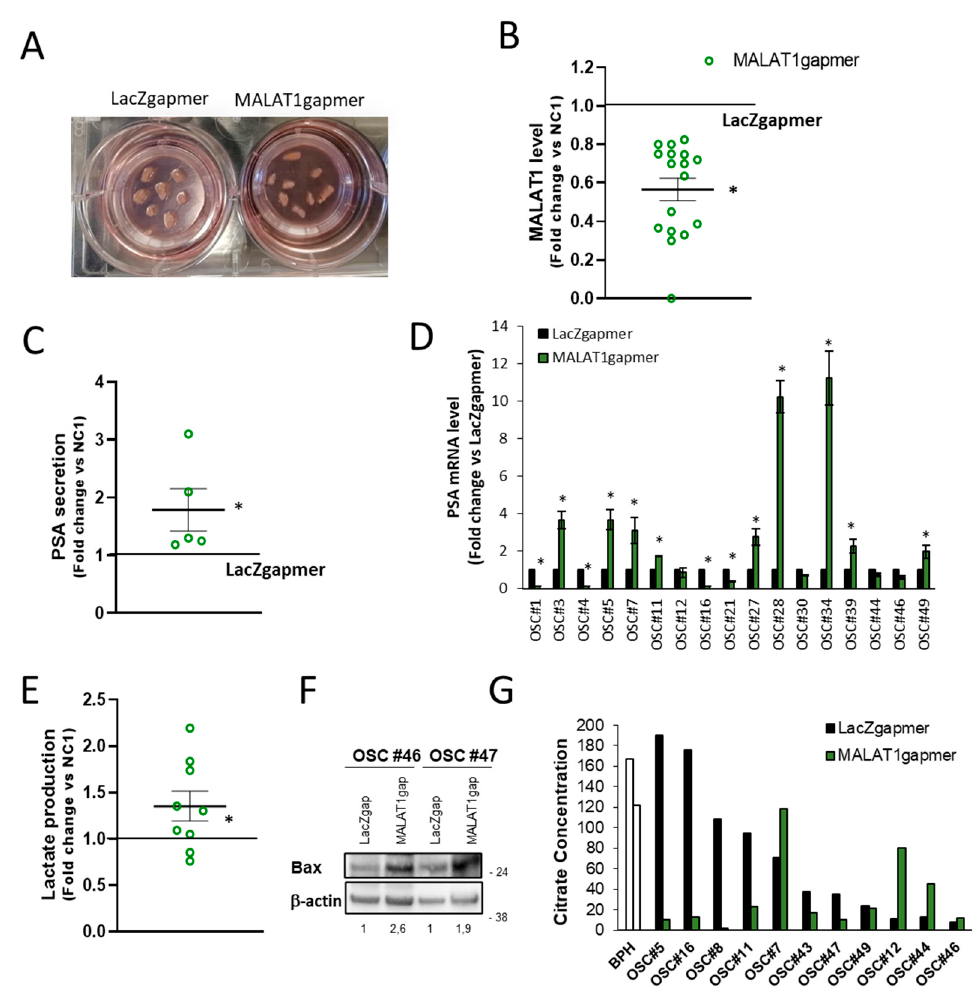
Figure 8. Organotypic slice cultures of prostate tumors and in vivo effects of MALAT1 depletion. ( A ) Image of representative human PCa organotypic slice cultures (OSCs) obtained from intra-operatory prostate cancer specimens transfected with specific (MALAT1) or control (LacZ) gapmer. ( B ) MALAT1 expression level was quantified by qRT-PCR in OSCs ( n = 17) at 72 h after transfection with specific MALAT1gapmer or LacZgapmer. ( C ) PSA concentration measured in the extracellular medium of OSCs ( n = 5) at 24h after transfection with MALAT1gapmer or LacZgapmer. ( D ) PSA mRNAs in 17 OSCs as in ( B , E ). Lactate concentrations analysis assessed using a colorimetric assay in the supernatant of OSCs ( n = 9) at 24 h after transfection with MALAT1 silencing. Results are plotted as fold change vs. LacZgapmer (placed to 1 and depicted as a black line). Individual values ( n = 3) with mean ± SEM are showed (green circles for MALAT1 gapmer). Non-parametric paired two-tailed Student’s t -test determined statistical significance. * p ≤ 0.05 MALAT1gapmer vs. LacZgapmer. ( F ) Representative western blot of BCL2 Associated X (BAX) after MALAT1 silencing in OSCs β -actin was used as a loading control. Numbers represent the fold induction vs. LacZgapmer normalized to loading control. A molecular weight marker is indicated. Uncropped Western Blots of Figure 8F are available in Figure S15 ( G ) Citrate concentrations analysis by colorimetric assay in the cell culture supernatant of normal/benign hyperplastic prostate (BPH) and in several PCa-derived OSC before and after MALAT1gapmer collected after 48 h of interference. Citrate concentration was normalized to relative β actin level. OSC #5, #16, #11, #7, #49, #12, #44, #46 exhibited an efficient MALAT1 depletion. Results are plotted mean ±